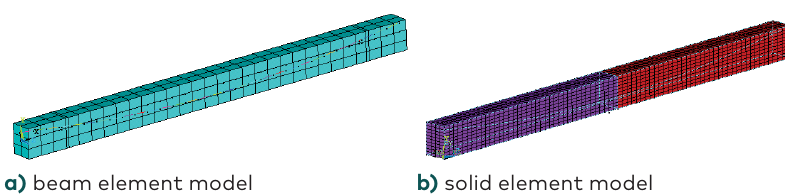
a) beam element model Figure 4. Finite element model of simply supported beams